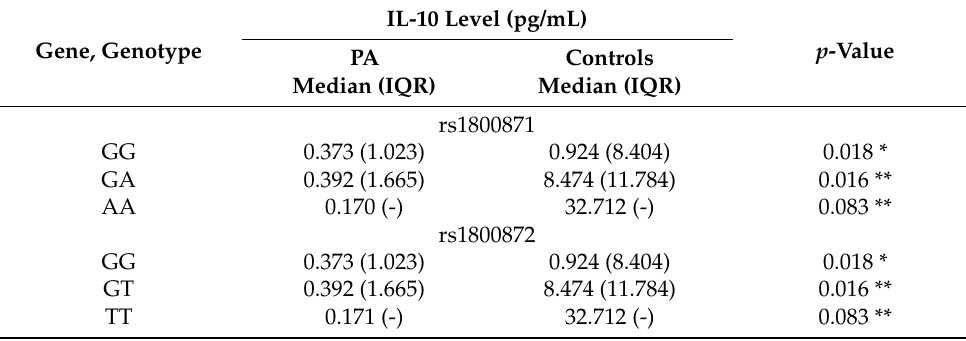
Table 4. Genotype distribution and serum IL-10